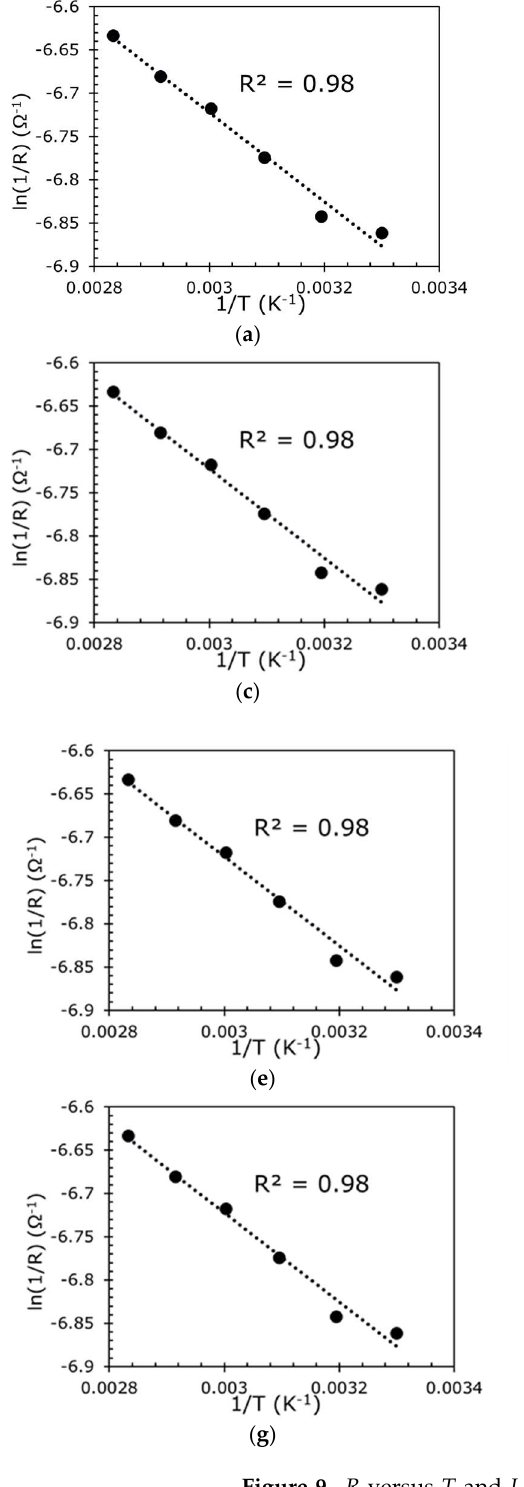
( b ) Figure 10. ( a ) Scanning electron microscope (SEM) image of the 3D rGO structure. ( b ) Illustration showing the collapse of the 3D rGO of the sensor under high pressure, acting as quasi-bulk material. 2.3.3. Region III: Conduction Mechanism of the Sensor at High Pressure > 30 kPa As can be seen in Figure 8b, the compressive strain change is only 17% when the pressure is increased from 30 kPa to 77 kPa. One reason could be that as the pressure increases beyond 30 kPa , the amount of compression is restricted by the sensor’s film thickness and further restricts the squeezing of the rGO structure. Therefore, almost all the 3D rGO structures collapse and behaves as a bulk material, causing the resistance to reduce slightly and then plateau off so no further collapse of the 3D rGO chain structure can occur (Figure 4b). 3. Conclusions Experiments were performed to study the conduction mechanisms of the piezoresis- tive rGO-based sensor from 0 kPa to 77 kPa. The increase in resistance to pressure exhibits three distinct regions. This could indicate the presence of two conduction mechanisms, which were investigated by measuring the variation in resistance with the temperature at